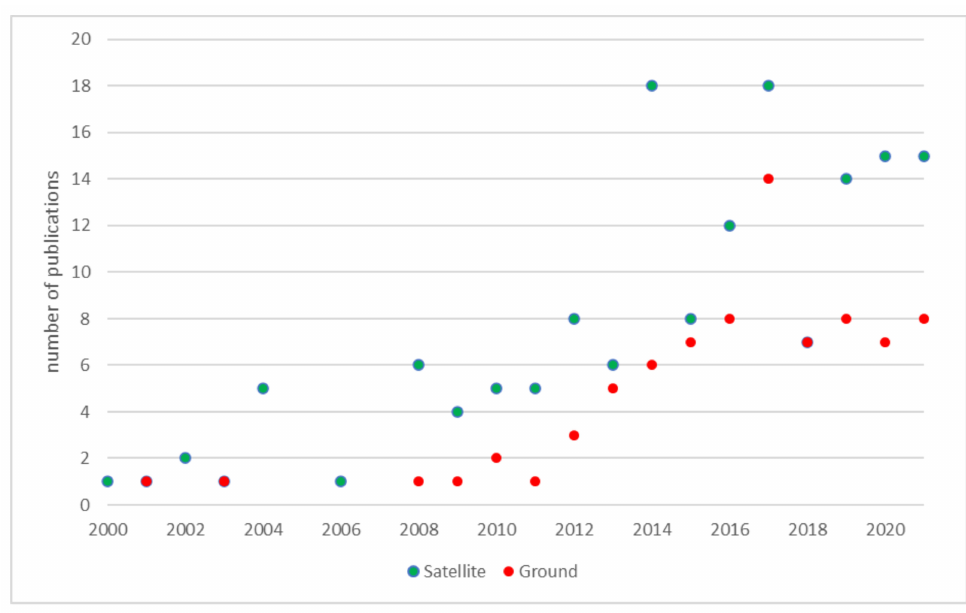
Figure 10. Variation in the number of publications based on satellite and ground-based